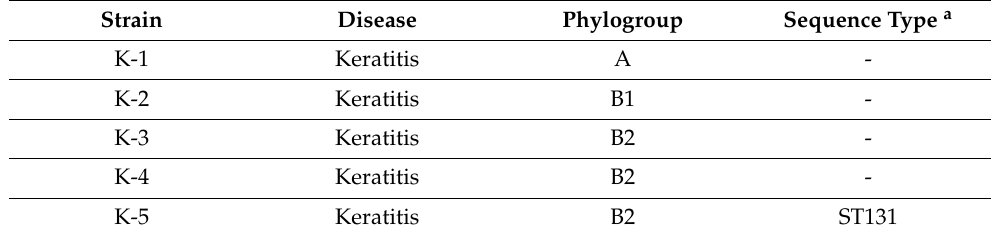
Table 1. Phylogenetic profile and sequence type of Escherichia coli strains isolated from eye infections.